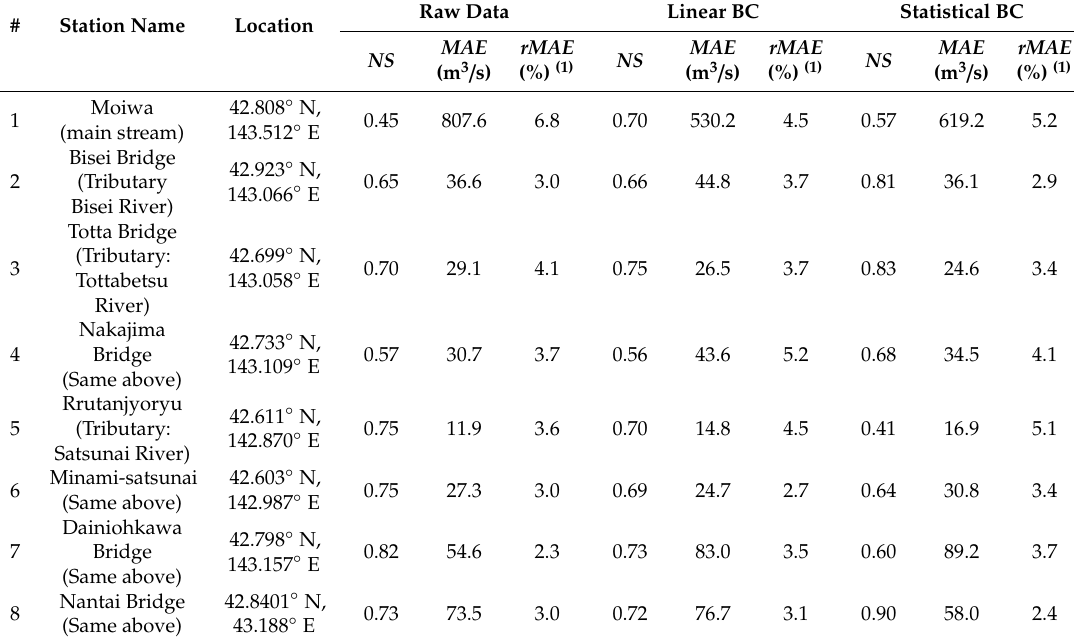
Table 3. Validation of model simulation at discharge